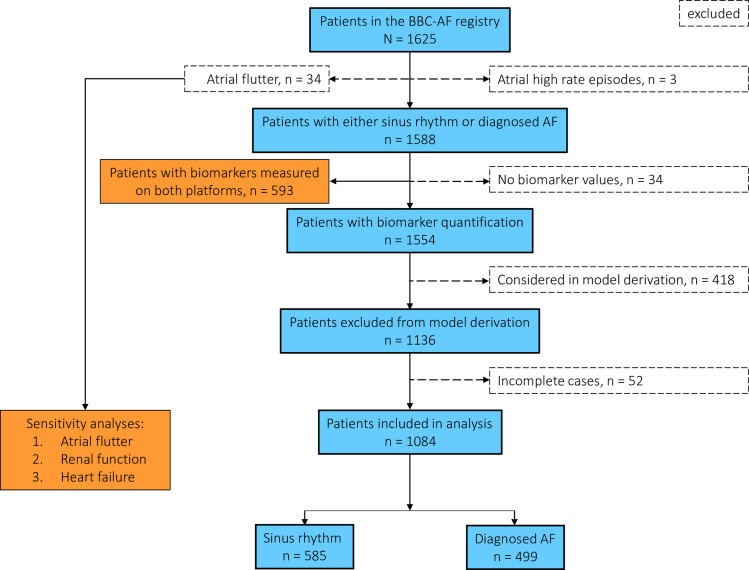
Flowchart of patients included in the analysis.A total of 1,084 patients were included in the validation study. Silent or asymptomatic AF patients detected using 7-day ECG monitoring were reassigned to the AF group. Blue boxes indicate the main analysis, orange boxes indicate additional and sensitivity analyses. AF, atrial fibrillation; BBC-AF registry, Birmingham and Black Country Atrial Fibrillation Registry.